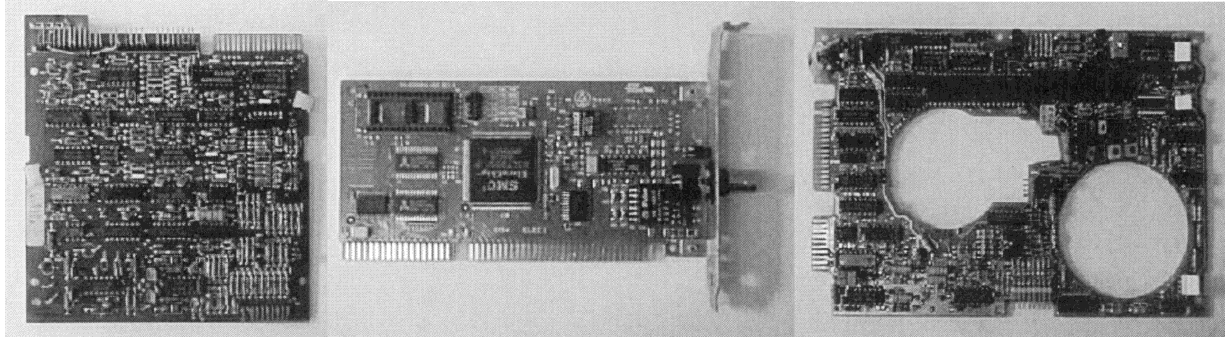
Figure 3. PCBs used in the study, without cables, wires and